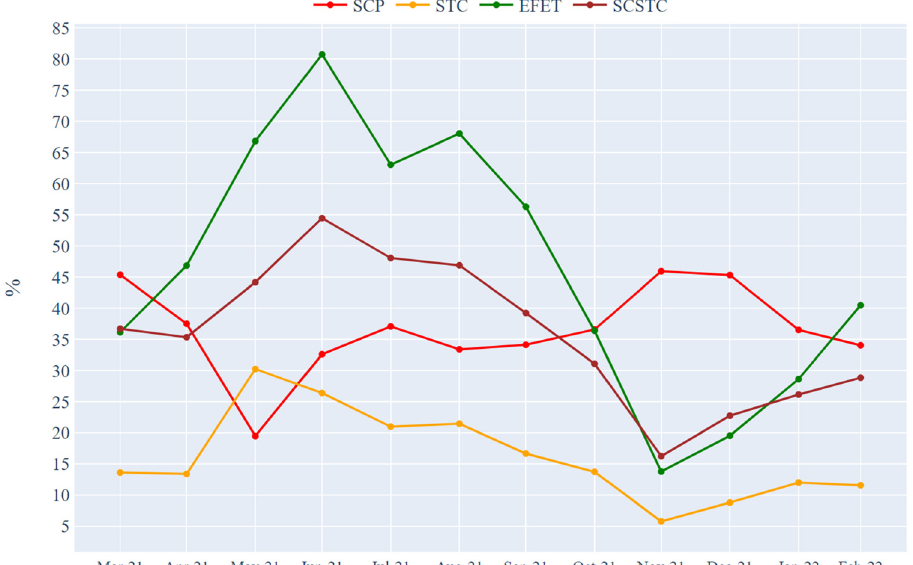
Figure 7. SCP, STC, EFET, and SCSTC parameters—monthly details.